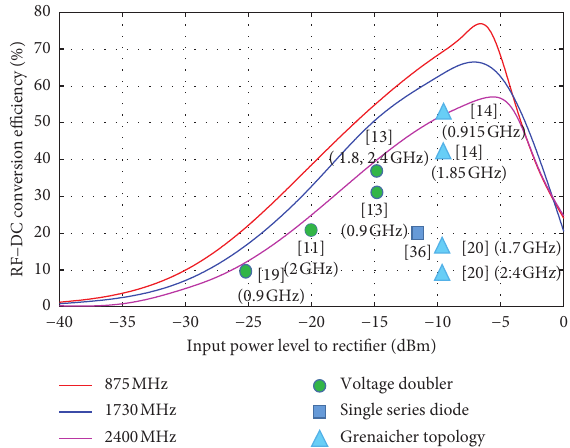
Figure 34: Comparison of conversion efficiency of proposed rectifier with existing topologies.